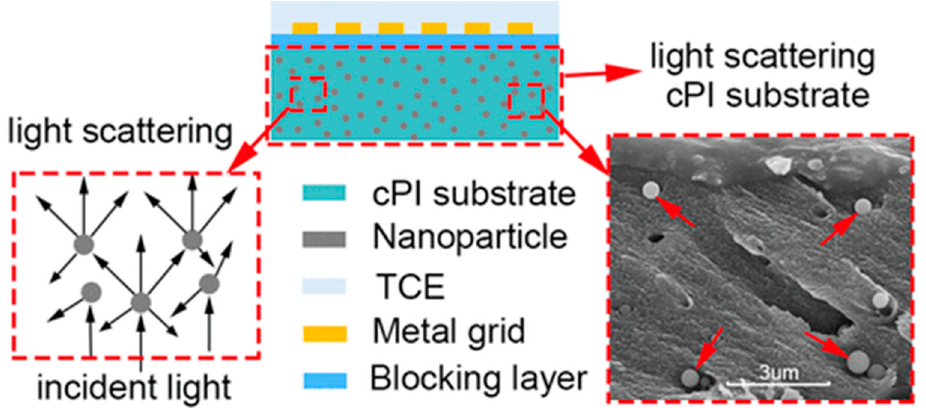
Figure 10. Schematic diagram of scattering layer and metal grid in PI substrate. Reprinted with permission from Ref.[116]. 2017, ACS Publications.